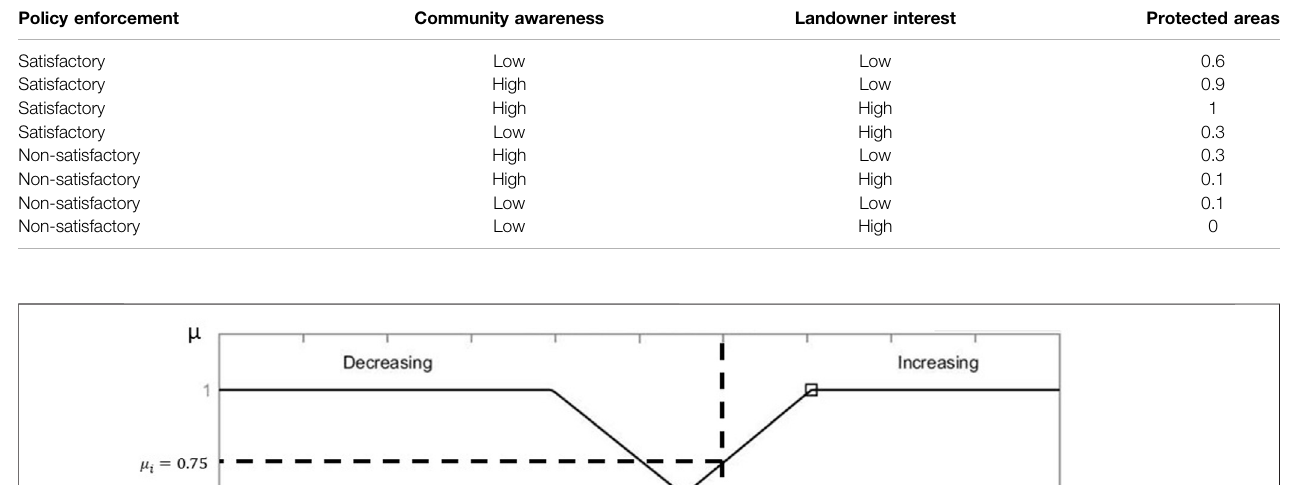
TABLE 3 | Results of the FCM for the variable “ protected areas. ”